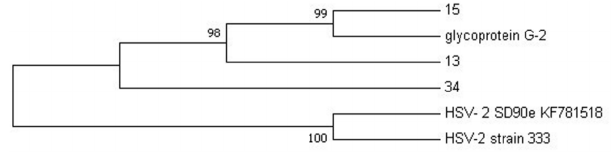
Figure 2. The evolutionary relationship between HSV-2 sequences (13, 15 and 34) and HSV-2 reference genomes was inferred using the maximum likelihood phylogeny method.